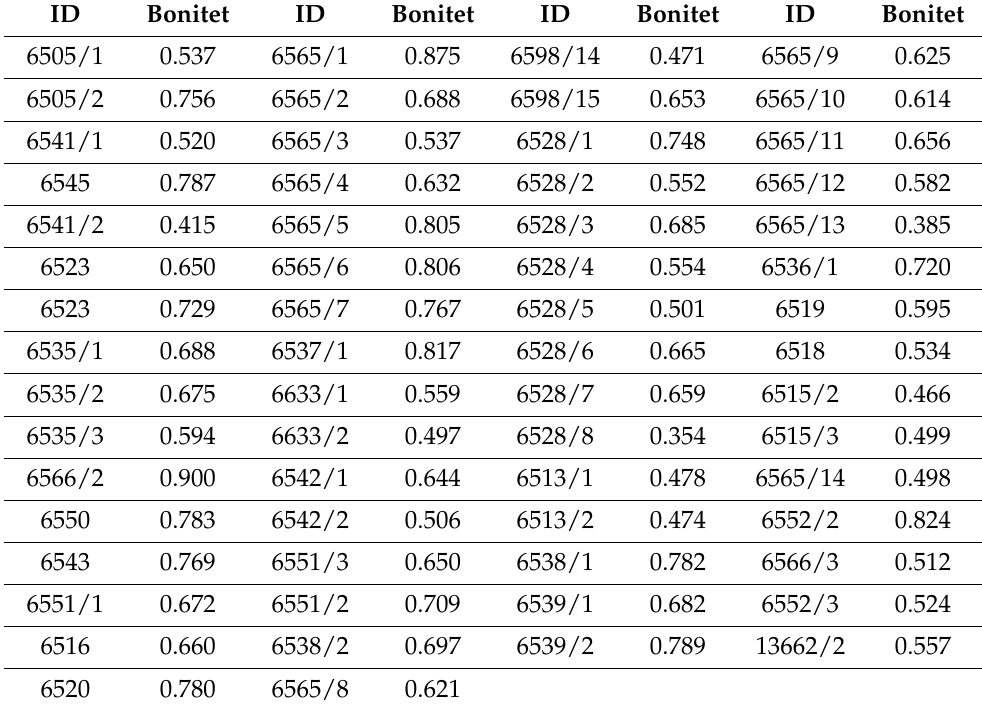
Table 11. Bonitet values of private cadastral